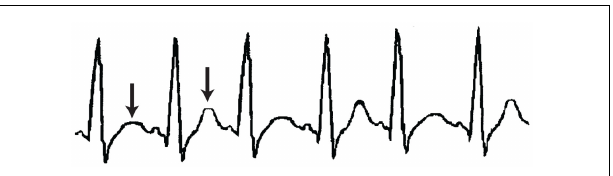
FIGURE 1 |T-wave alternans on the ECG. Large amplitude alternations in theT-wave (arrows) are seen in this example.ThisTWA is indicative of an underlying alternation in the action potential durations of cardiac myocytes. Adapted from Narayan (2006).